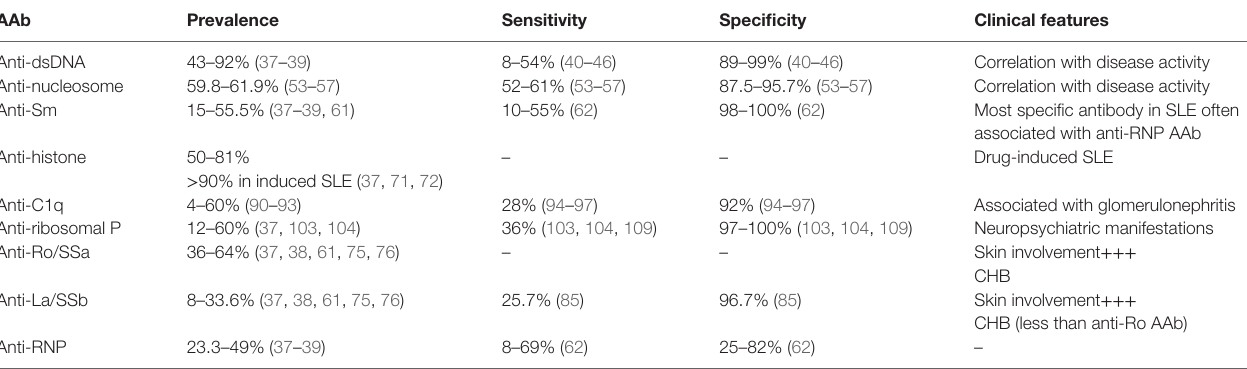
TAble 2 | AAb associated with systemic lupus erythematosus (SLE).